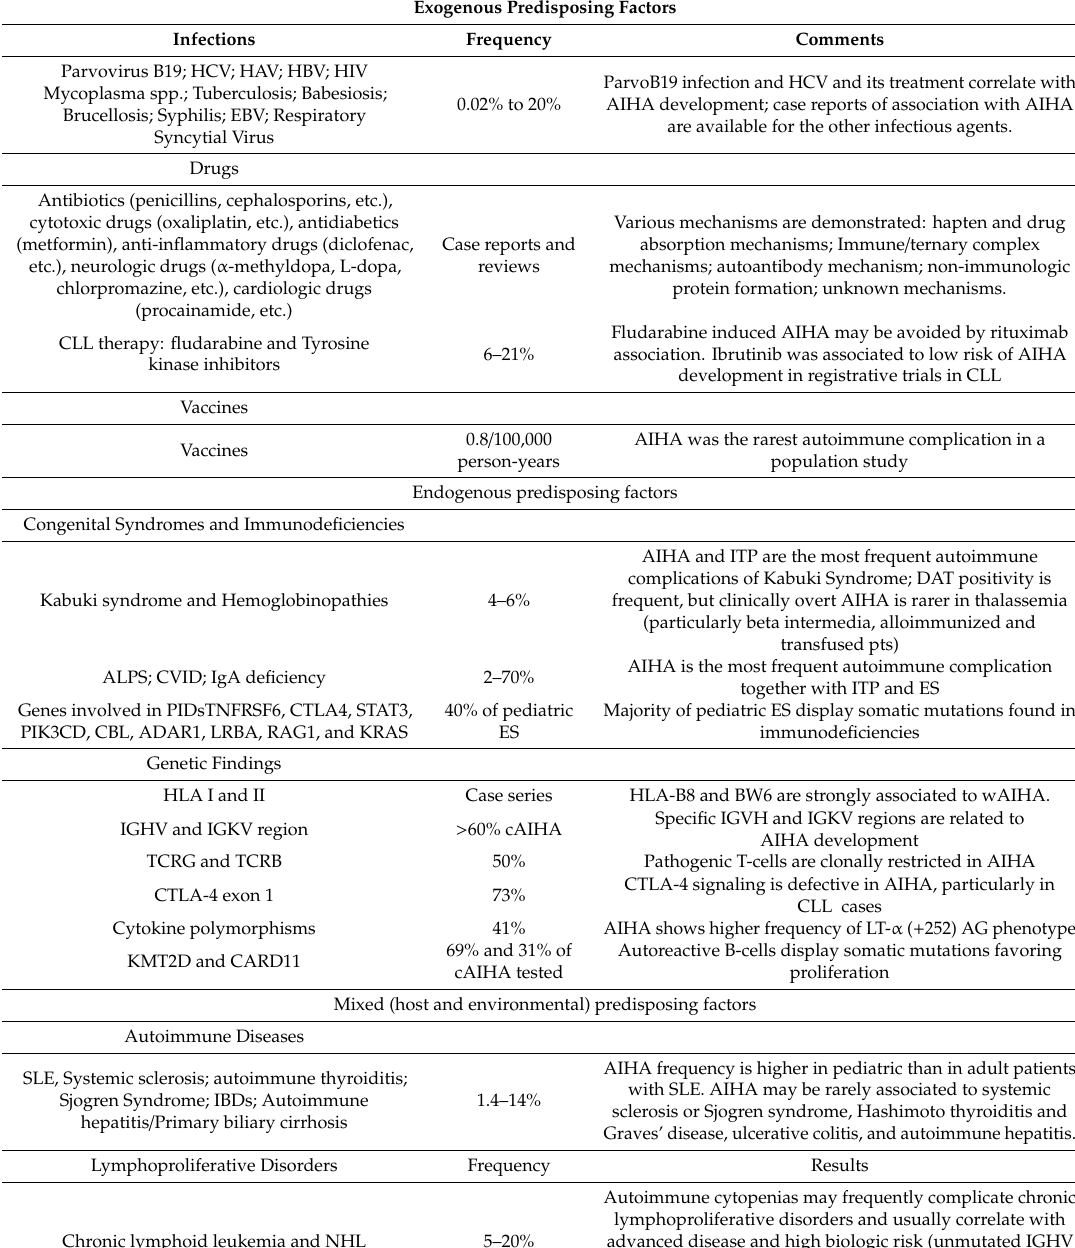
Table 1. Secondary conditions associated with autoimmune hemolytic anemia